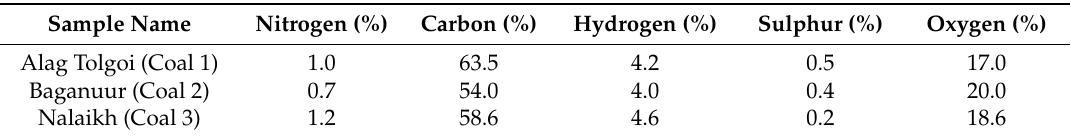
Table 1. Elemental analysis of coal